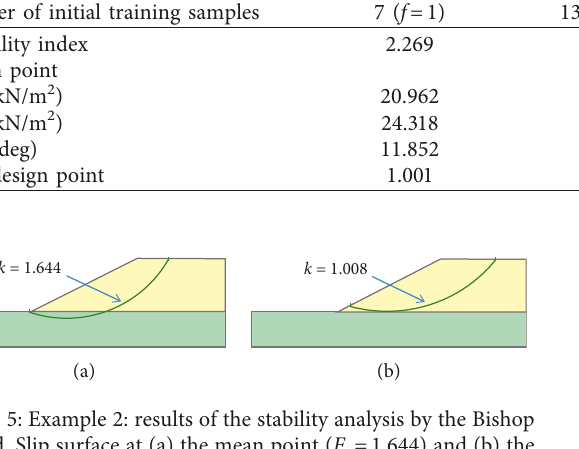
1.656) and (b) the (cid:28)